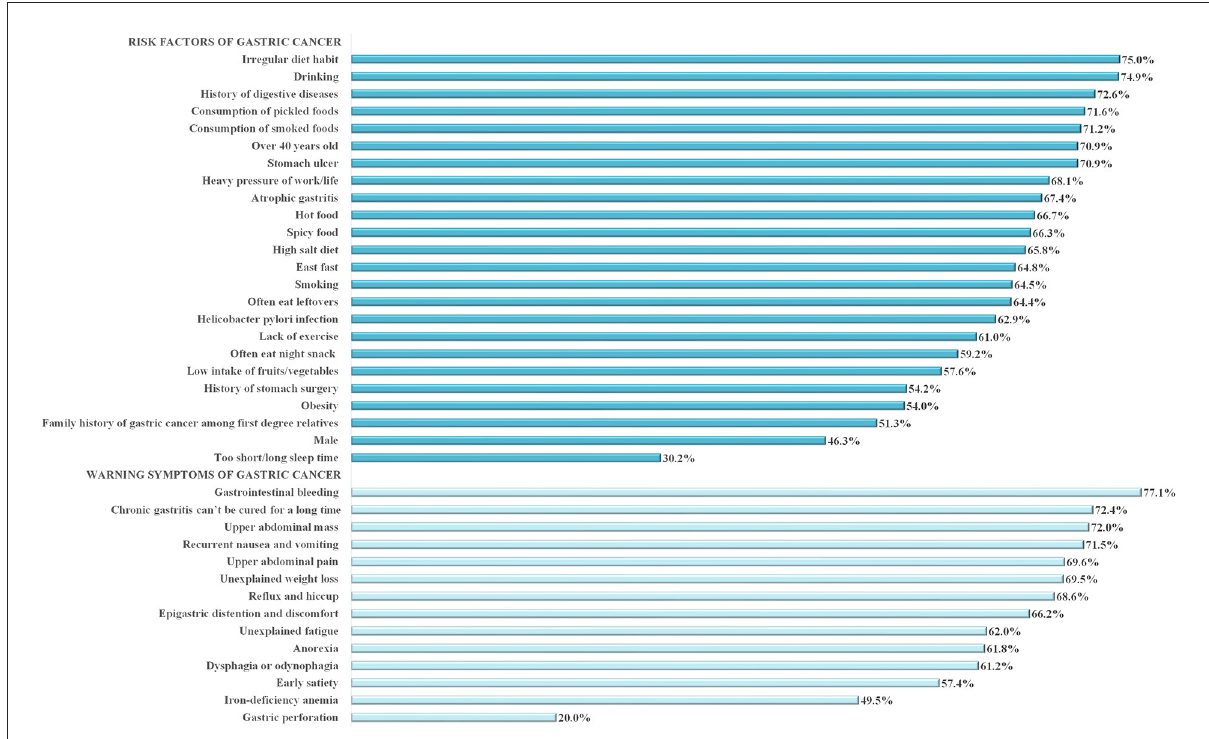
FIGURE1 Percentages of correct responses to knowledge items ( N =